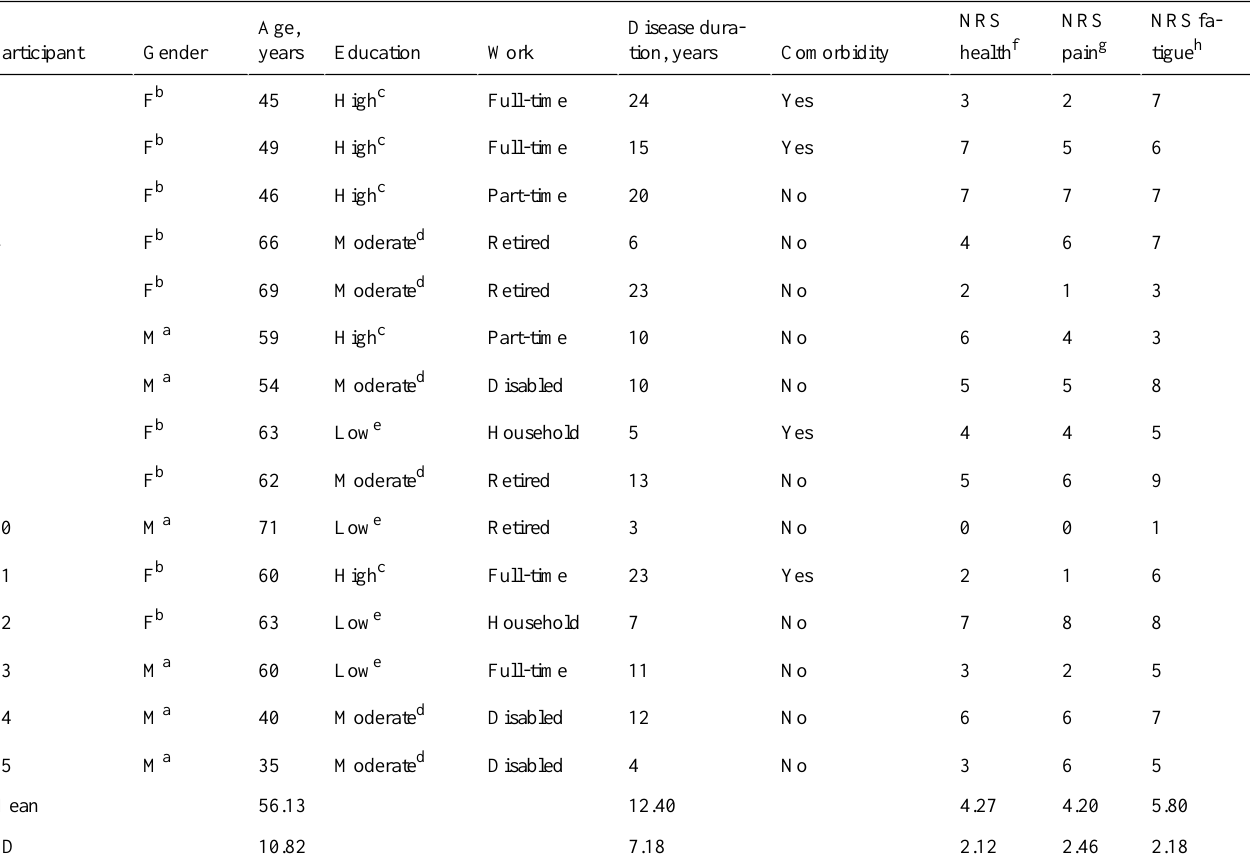
Table 1. Overview of